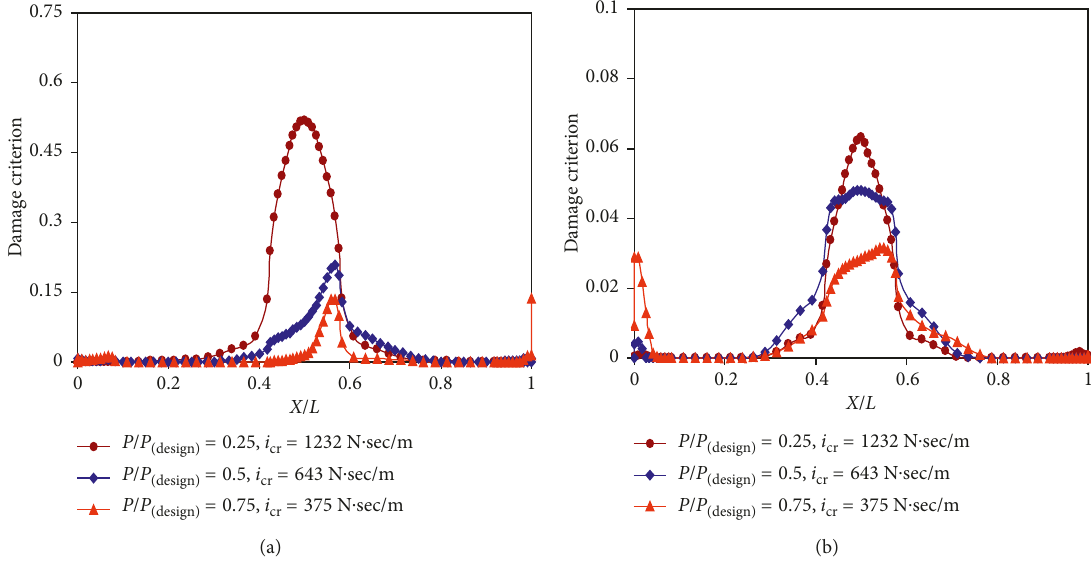
Figure 14: Damage initiation criterion profile of simply supported column W150 of the tension flange; (b) at the middle of the web.